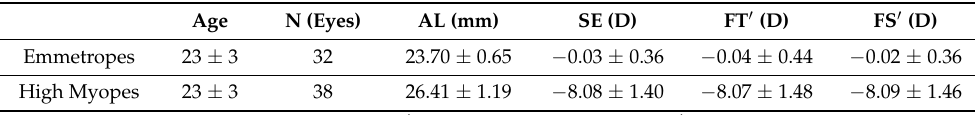
Table 1. Descriptive data of the subjects enrolled in the